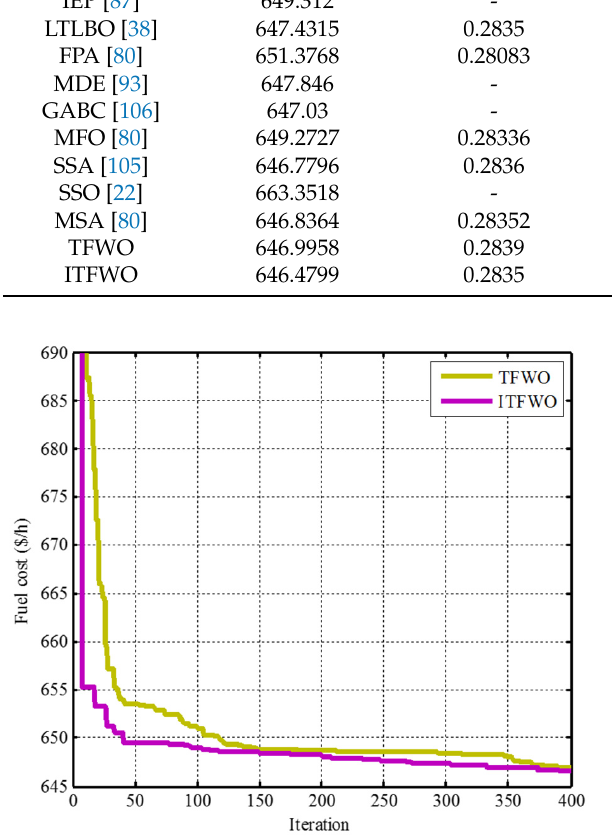
Table 5. The optimization results for Type 4. Optimizer